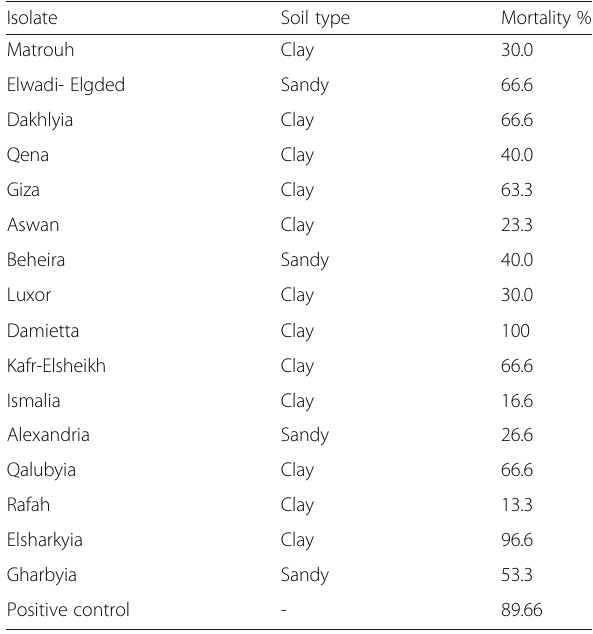
Table 2 Toxicity of Bacillus thuringensis isolates against the